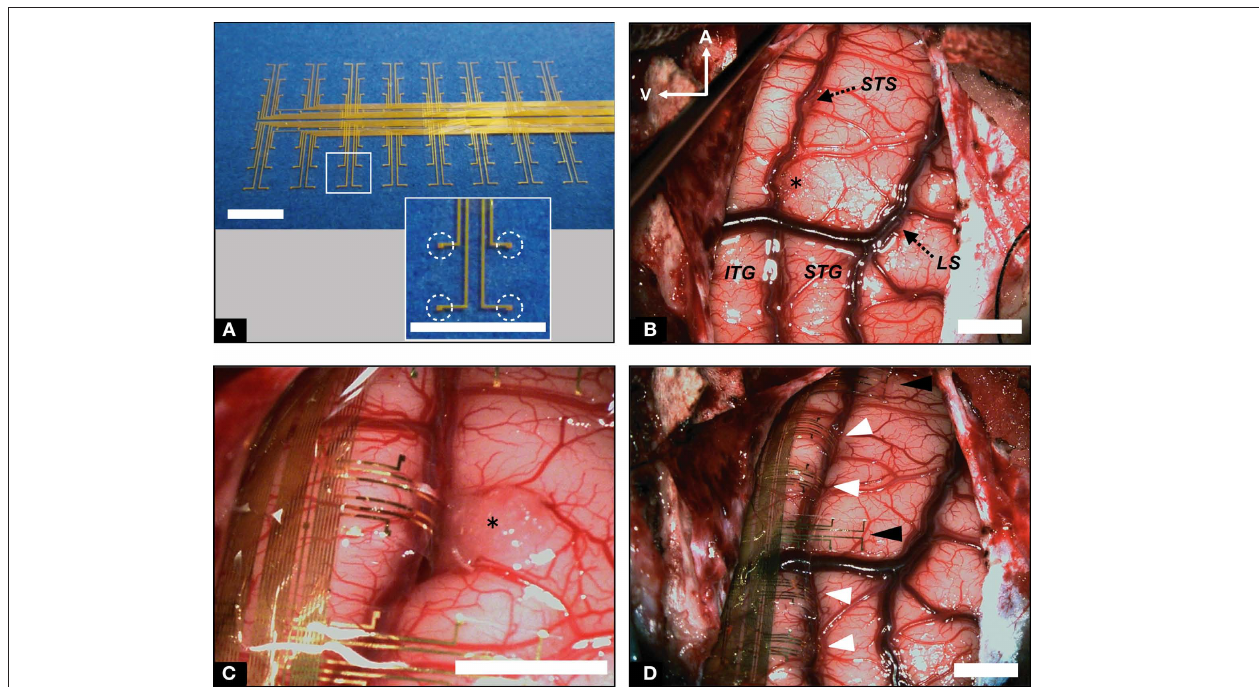
FigurE 3 | implantation of recording ECog probe into STS and iTg. (A) Flexible electrode array to be implanted into STS. Individual electrode contacts are shown in the inset (dotted circles). (B) Low-magnification view of the left temporal lobe before probe implantation. STS was dissected from surface to bottom; LS ,